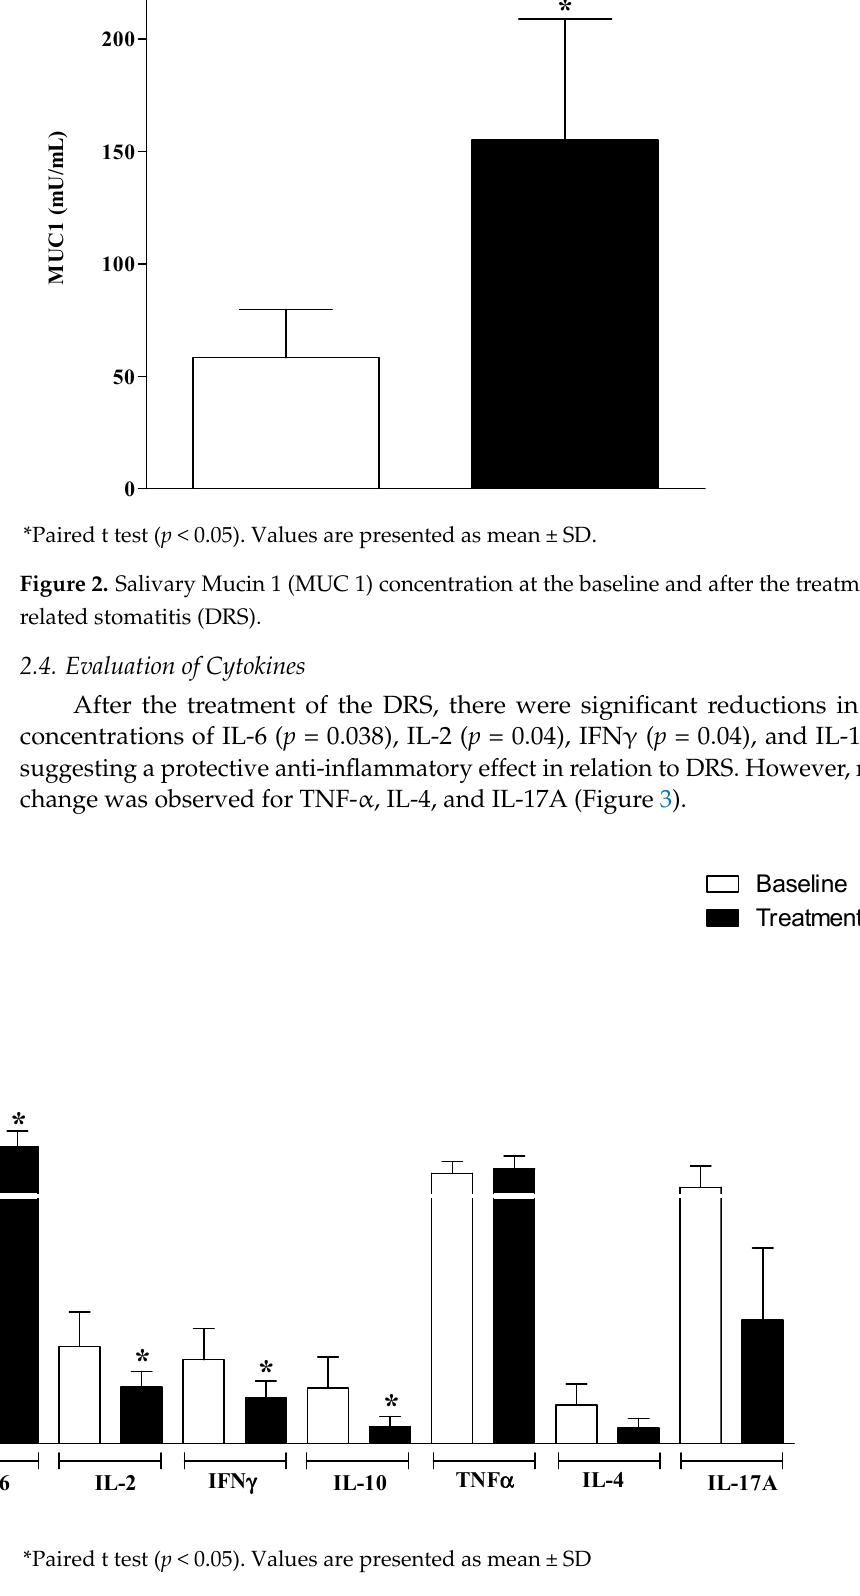
Figure 3. Salivary cytokines at the baseline and after the treatment of denture-related stomatitis (DRS).